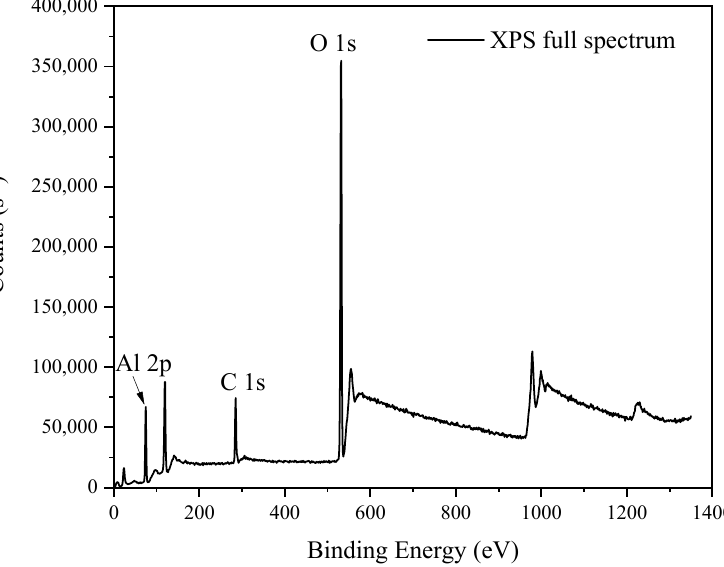
Figure 2. X-ray photoelectron spectroscopy (XPS) Full spectrum taken on the surface of Al 2 O 3 thin film.